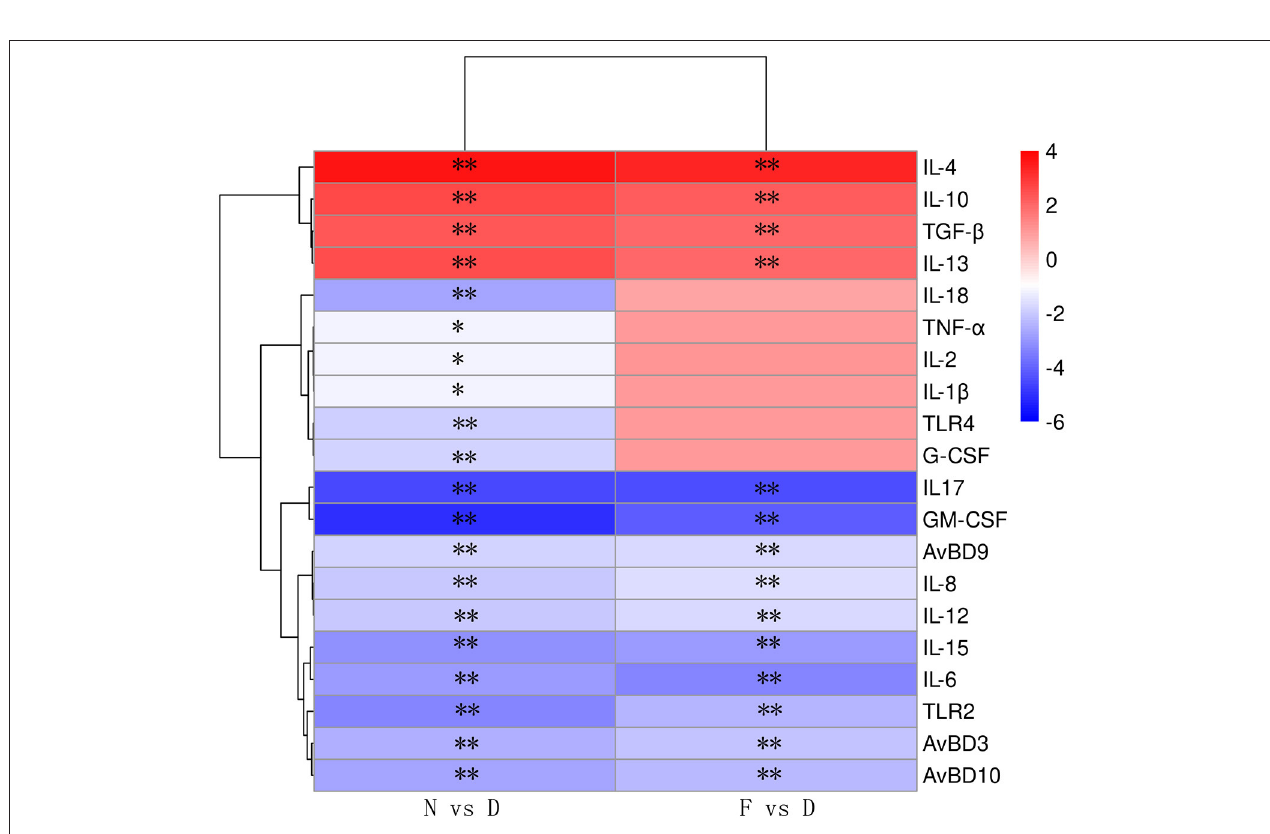
FIGURE 3 | The relative mRNA expression levels of immune-related genes are shown using the indicated pseudo color scale ( n = 6). Lung samples were collected in the 48 day of age without MG challenge. **Indicates P <